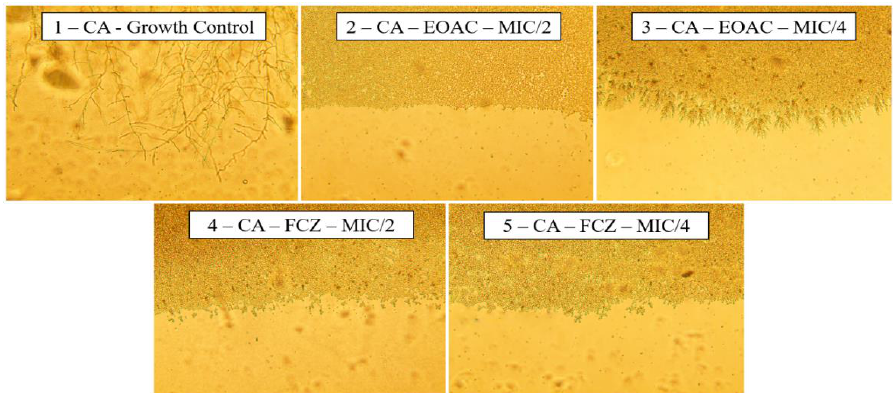
Figure 4. Effects of Acritopappus confertus essential oil on the morphological aspects of Candida albi- cans . Slide (S1): Growth control; (S2): Effect of essential oil at a concentration of 128 µg/mL; (S3): Effect of essential oil at a concentration of 64 µg/mL; (S4): Effect of fluconazole at a concentration of 1024 µg/mL; (S5): Effect of fluconazole at a concentration of 512 µg/mL. Display 400× enlarged. For the C. krusei strain, fluconazole decreased virulence at the two concentrations evaluated (512 µg/mL and 256 µg/mL) (Figure 5, S4 and S5). At a concentration of 512 µg/mL, the essential oil of A. confertus also inhibited the growth of C. krusei (S2) hyphae similar to the positive control fluconazole; however, when evaluated at a concentration of 256 µg/mL, the oil did not show an effect on the virulence of the fungal strain (S3), pre- senting cytoplasmic projections similar to the growth control.